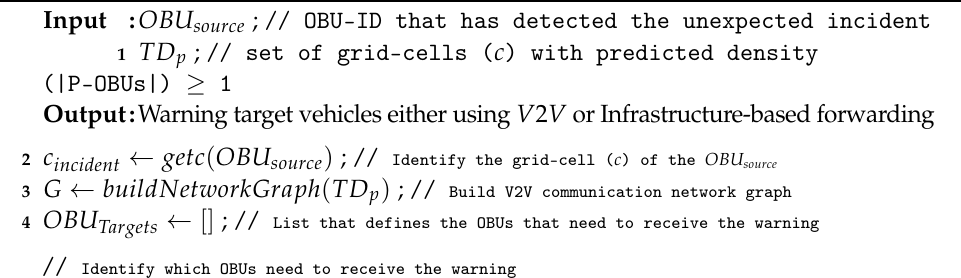
Algorithm 1: Hybrid early warning